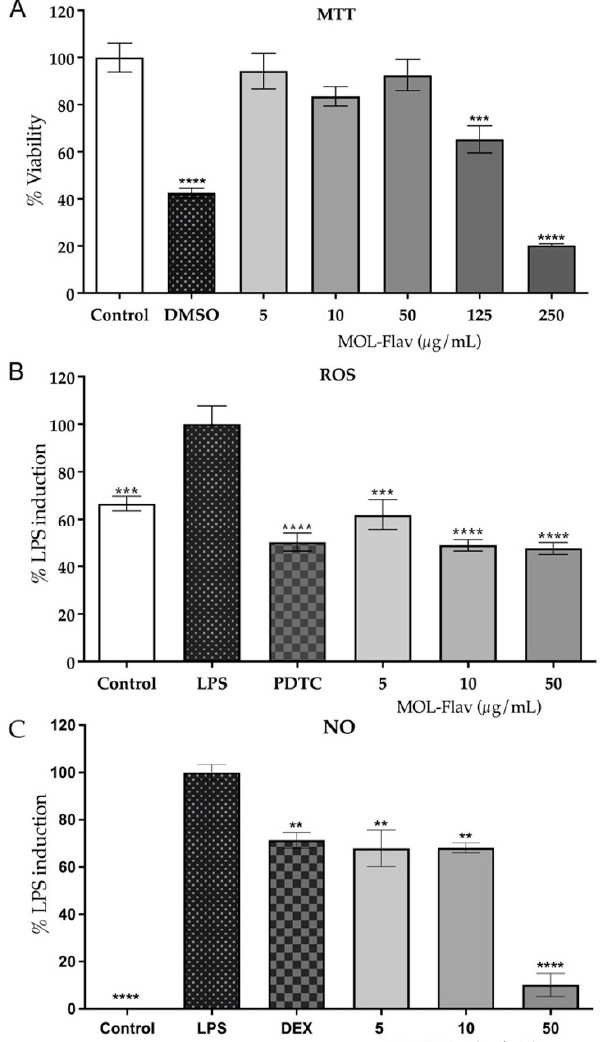
Figure 5. Cell viability (MTT) and the effect on intracellular reactive radical species (ROS) and nitric oxide (NO) of flavonoid-rich extract from M. oleifera leaves (MOL-Flav) on murine macrophage RAW 264.7 cells. ( A ) Inhibitory effects of MOL-Flav on RAW 264.7 cells, Control (80% ethanol), DMSO (1% dimethyl sulfoxide); ( B ) ROS production, Control (80% ethanol), LPS (100 μ g/mL, lipopolysaccharide), PDTC (10 μ M, pyrrolidinedithiocarbamate ammonium); ( C ) NO production. Control (80% ethanol), LPS (1 μ g/mL), DEX (10 μ M dexamethasone). Data represent the mean ± SEM from three independent experiments. One-way ANOVA was followed by the post hoc Dunnett test. *** p < 0.001, **** p < 0.0001 vs. Control group (MTT). ** p < 0.01, *** p < 0.001, **** p < 0.0001 vs. LPS-treated cells (ROS and